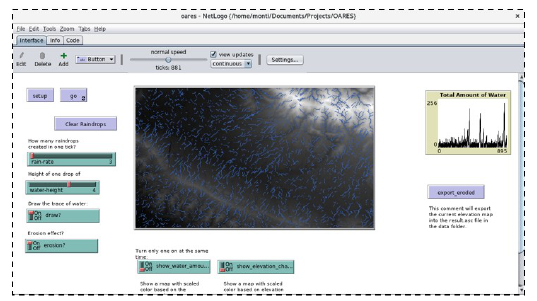
Figure 11. NetLogo Interface showing Rainfall Traces.